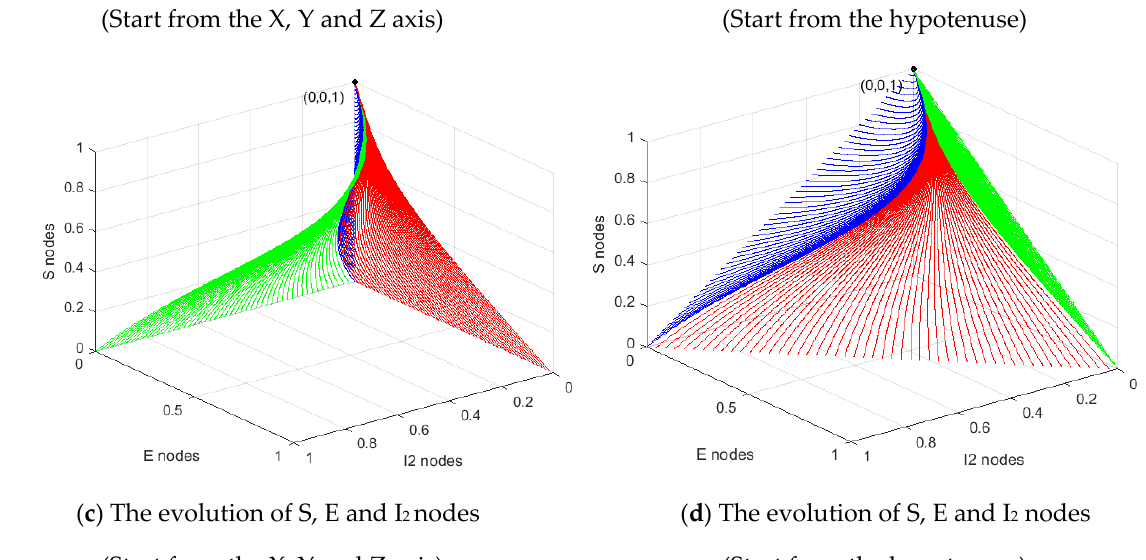
Figure 2. The evolution of state variables when R 0 < 1.